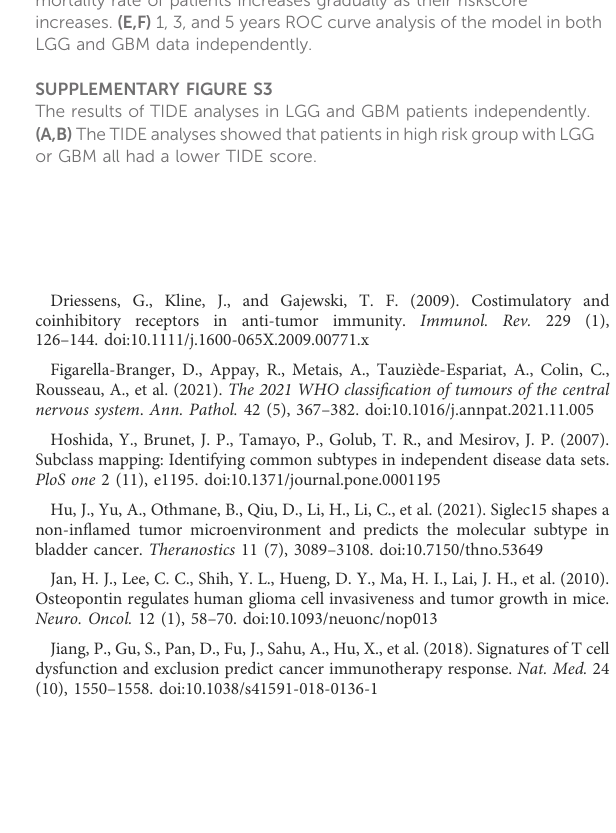
SUPPLEMENTARY FIGURE S1 Differential expression analyses and the clinical analyses in microarray datasets. (A,B) Results of differential expression analyses showed that patients with glioma had in a higher level of the signature genes in tumor tissues both in GSE4290 (A) and GSE108474 series (B) . And patients with advanced stage qqhad a higher level of riskscore (C,D) . SUPPLEMENTARY FIGURE S2 ThevalidationofthemodelusingLGGandGBMdataindependently. (A,B) KM survival curve analysis of the model. (C,D) The plots shows that the mortality rate of patients increases gradually as their riskscore increases. (E,F) 1, 3, and 5 years ROC curve analysis of the model in both LGG and GBM data independently. SUPPLEMENTARY FIGURE S3 The results of TIDE analyses in LGG and GBM patients